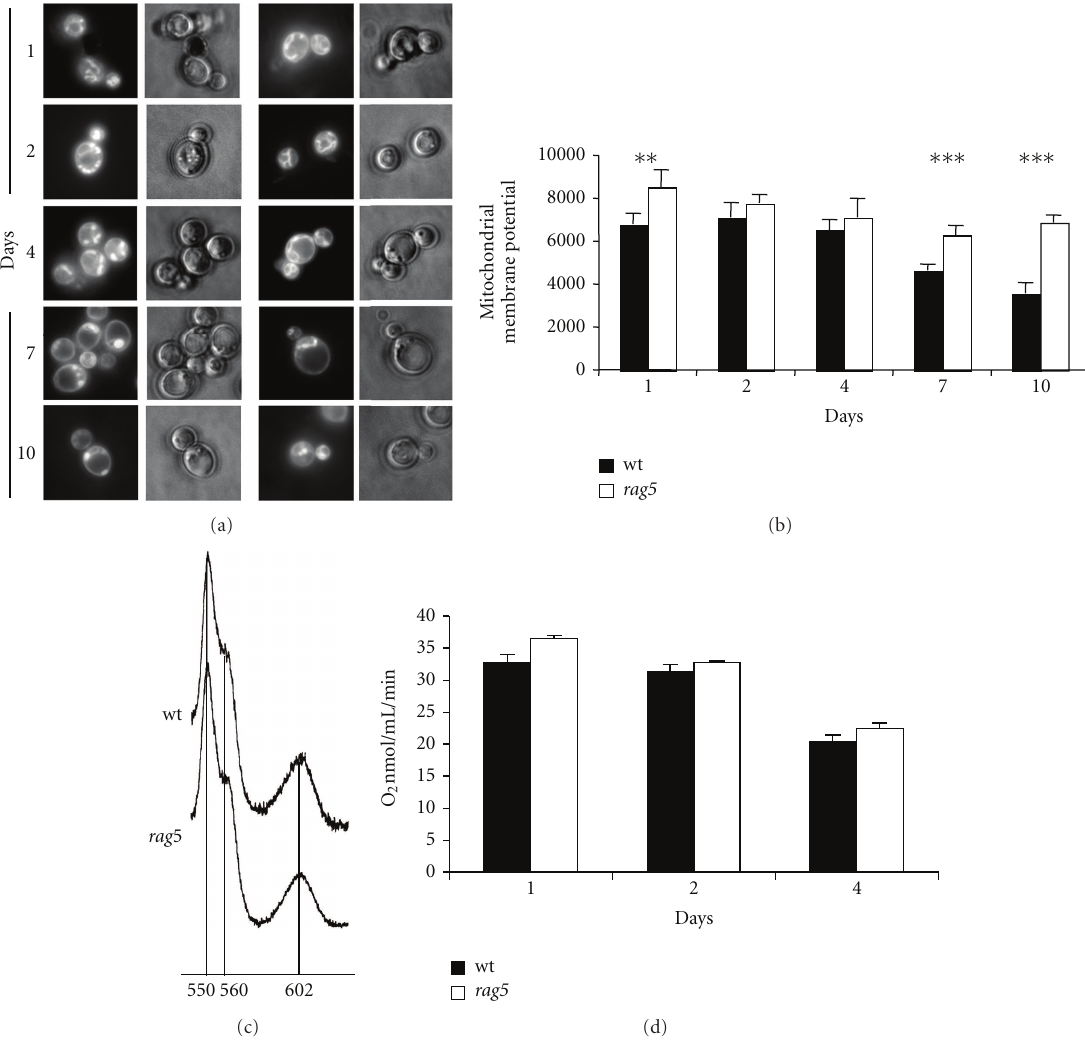
Figure 4: Functional analysis of mitochondria in the long-lived mutant. (a) Comparison of mitochondrial morphology of rag5 Δ and wt strains after growth in YPD medium. Analysis was performed by taking aliquots at the indicated times and observing cells after DASPMI staining at the fluorescence microscopy. (b) Mitochondrial membrane potential determined by DiOC 6 staining and FACS analysis. Values are expressed as mean fluorescent intensity. Means of four biological replicates ± one standard deviation are graphed. ∗∗ P value from a Student’s t -test, < 0.01, ∗∗∗ P value from a Student’s t -test, < 0.001. (c) Cytochrome spectra. Cell samples were collected at day 1 and cytochrome spectra were evaluated. The peaks at 550, 560, and 602nm (vertical bars) correspond to cytochromes c, b, and aa3, respectively. The height of each peak relative to the baseline of each spectrum is an index of cytochrome content. Data are representative of three independent experiments, repeated with similar results. (d) Oxygen consumption rates in wt and rag5 Δ cells. Cell samples were collected at days 1, 2, and 4 and oxygen consumption was measured at 30 ◦ C using a Clark type oxygen electrode. Data are means ± s.d. of three independent experiments. Data were normalized for the number of live